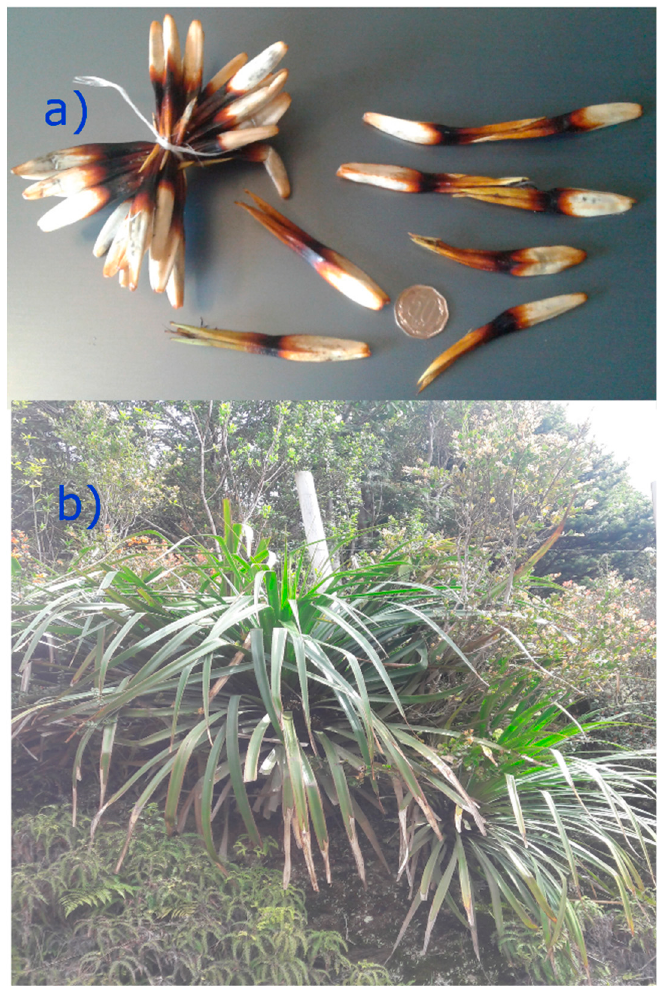
Figure 1. Greigia sphacelata (Ruiz and Pav.) Regel ( Bromeliaceae ). ( a ) Fruits, ( b ) plant.